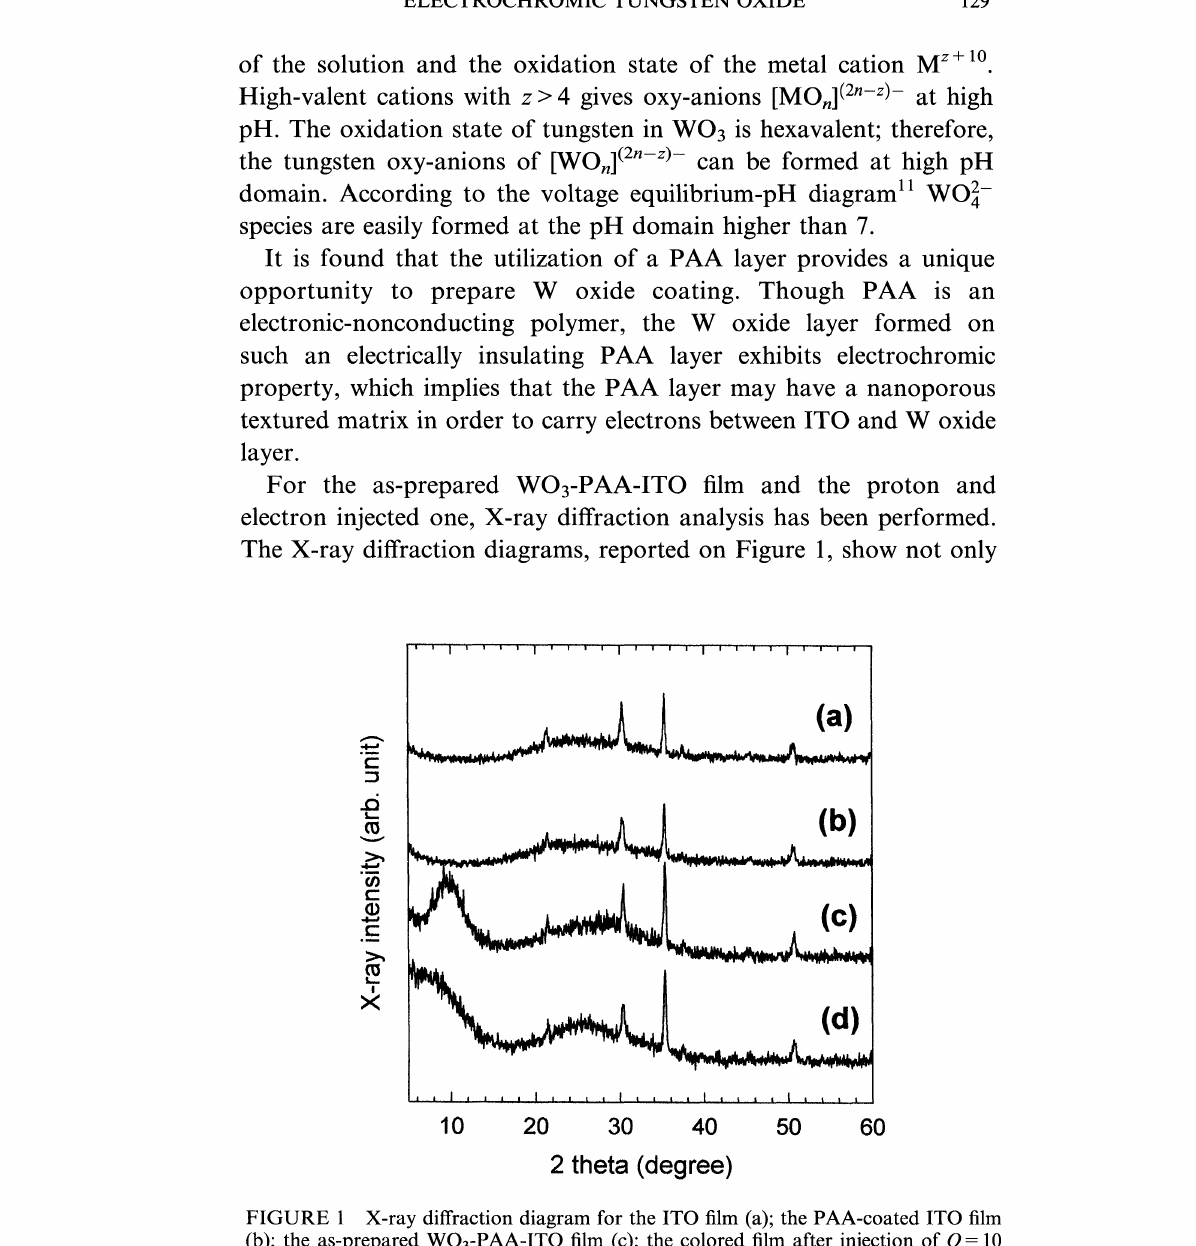
X-ray diffraction diagram for the ITO film (a); the PAA-coated ITO film (b); the as-prepared WO3-PAA-ITO film (c); the colored film after injection of Q= 10 mC/cm in N HC1